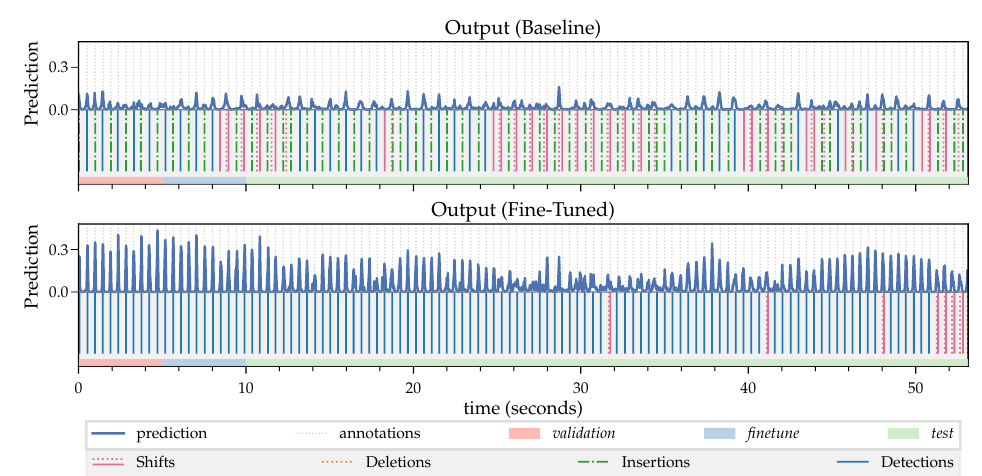
Figure 6. Network outputs for the baseline and fine-tuning approaches on Blue Moon . The validation region is composed by the 5s after the first beat annotation (red), the finetune region by the following 5s (blue) and the test region starting immediately after and going until the end of the excerpt (green). The dark blue solid line indicates the network prediction. The vertical grey dotted lines show the ground truth annotations. The vertical light blue solid lines show the correct beat detections. The incorrect beat outputs are notated with the required operation colour (delete—orange, shift—pink,